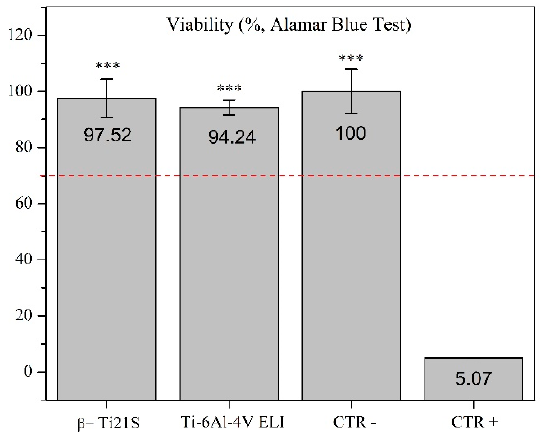
Figure 9. Viability results of the β -Ti21S (test), Ti–6Al–4V ELI (reference), and CTR − (cells without material) and CTR + (cells with a cytotoxic substance) controls measured by Alamar Blue test and expressed as a percentage of CTR − . Red-dashed line represents 70% of negative control, which is a cut-off line between cytotoxic and non cytotoxic effects. Kruskal–Wallis followed by the Mann–